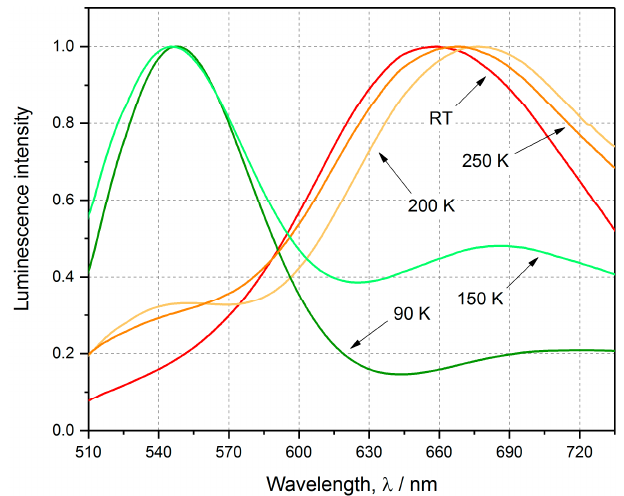
Figure 3. Emission spectra (smoothed and normalised) recorded for the Cu 4 crystal at different temperatures (excitation wavelength, λ ex = 355 nm). Table 3. The Cu 4 complex solid-state luminescence lifetimes ( τ ) and emission peak maxima ( λ em ) obtained from the least-squares fit at various temperatures ( T ). τ l and τ s denote longer and shorter lifetime, respectively; “r” and “g” superscripts denote parameters for red- and green-light emission maxima,